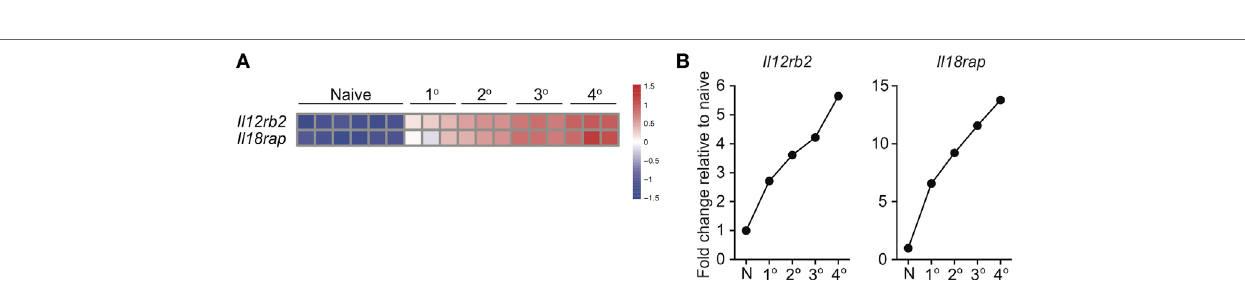
FigUre 4 | Expression of IL-12 and IL-18 receptor components increases with additional antigen encounters. 1°, 2°, 3°, and 4° memory OT-I cells were generated and microarray analysis was performed as described by Wirth et al. Relative gene expression was determined from the microarray date deposit available in the Gene Expression Omnibus database (http://www.ncbi.nlm.nih.gov/gds) under the accession number GSE21360. (a) Heatmap of expression of Il12rb2 and Il18rap for naïve, 1°, 2°, 3°, and 4° memory OT-I cells. (B) Fold change in expression of Il12rb2 and Il18rap for 1°, 2°, 3°, and 4° memory OT-I cells compared to expression for naïve OT-I cells.